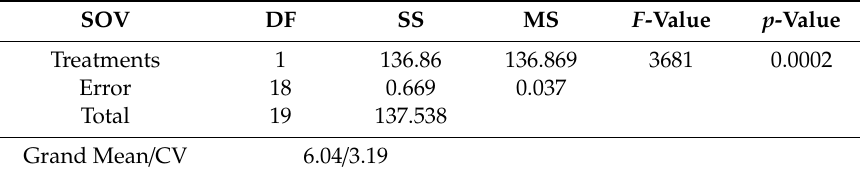
Table A13. Influence on the total amount of chlorophyll (SPAD) of PeBL1-treated and control cucumber seedlings.